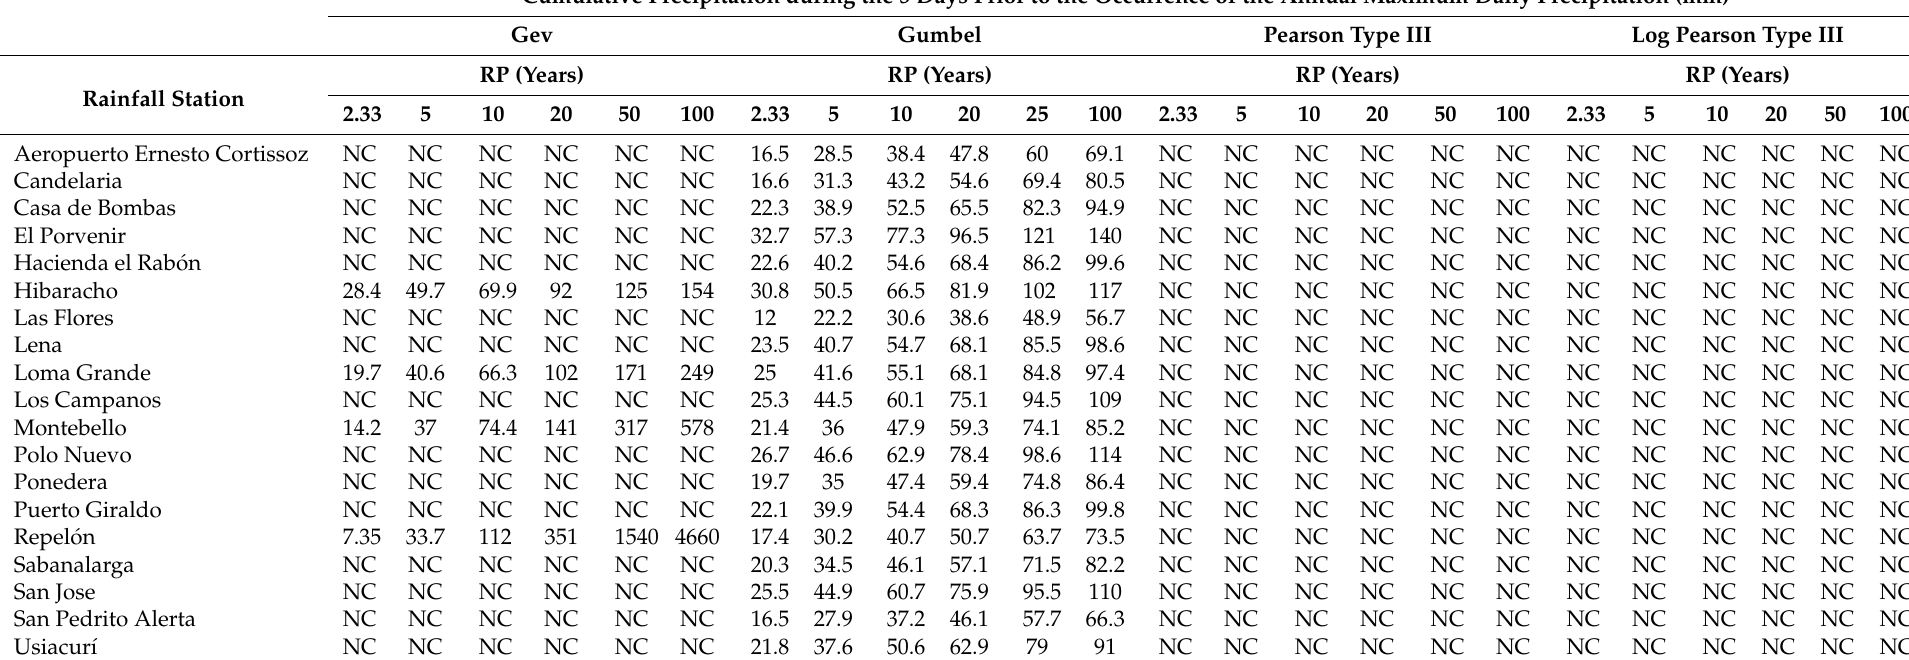
Table A1. Fit results of the cumulative precipitation during the 5 days prior to the occurrence of the annual maximum daily precipitation for different return periods using the different probability functions and maximum likelihood